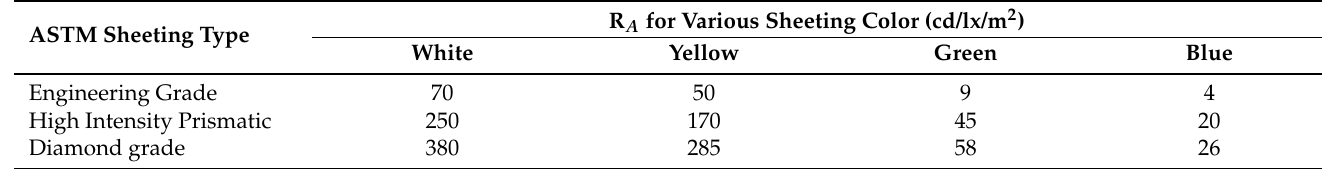
Table 3. Minimum R A values for new sheeting type classification as recommended by ASTM D4956. ASTM Sheeting